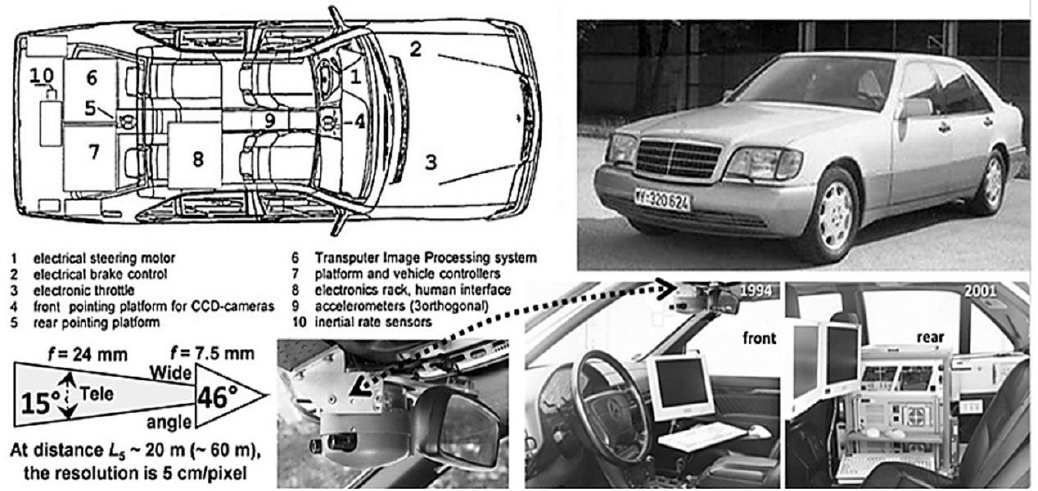
Figure 4. Demonstration vehicle VaMP of UniBwM (top right, a twin to the Daimler-VITA_2); top left: components for autonomous driving. Bottom right: A view into the passenger cabin with the first small bifocal “Vehicle eye” on a yaw-platform, detailed at bottom left.